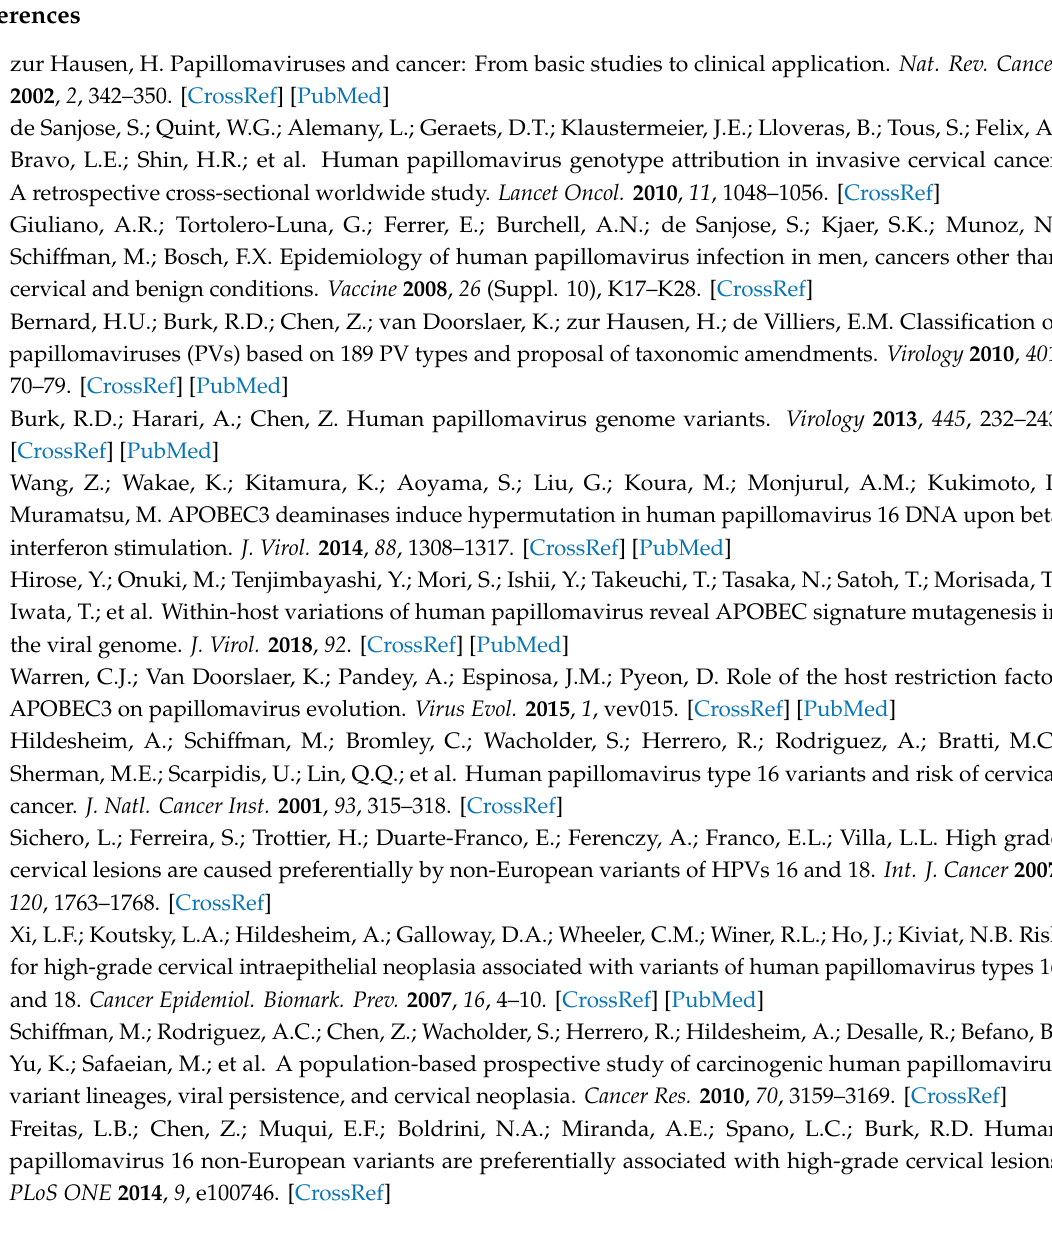
Figure S1: maximum likelihood phylogenetic tree of HPV16 whole-genome sequences, Table S1: HPV16 whole-genome sequences determined in this